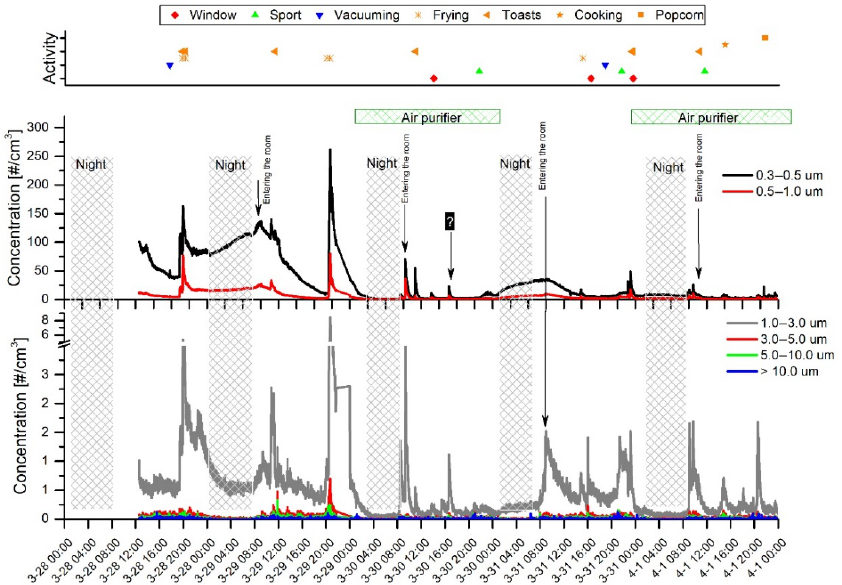
Figure 3. Time series of PN concentrations recorded with the OPC-N3 (AlphaSense). The horizontal green bars represent the periods of air purifier usage in the room.